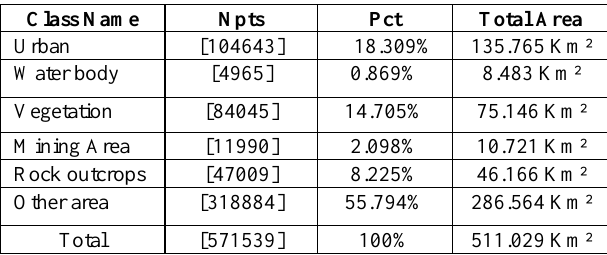
Table 6. Land cover/land use classes and area (2018)